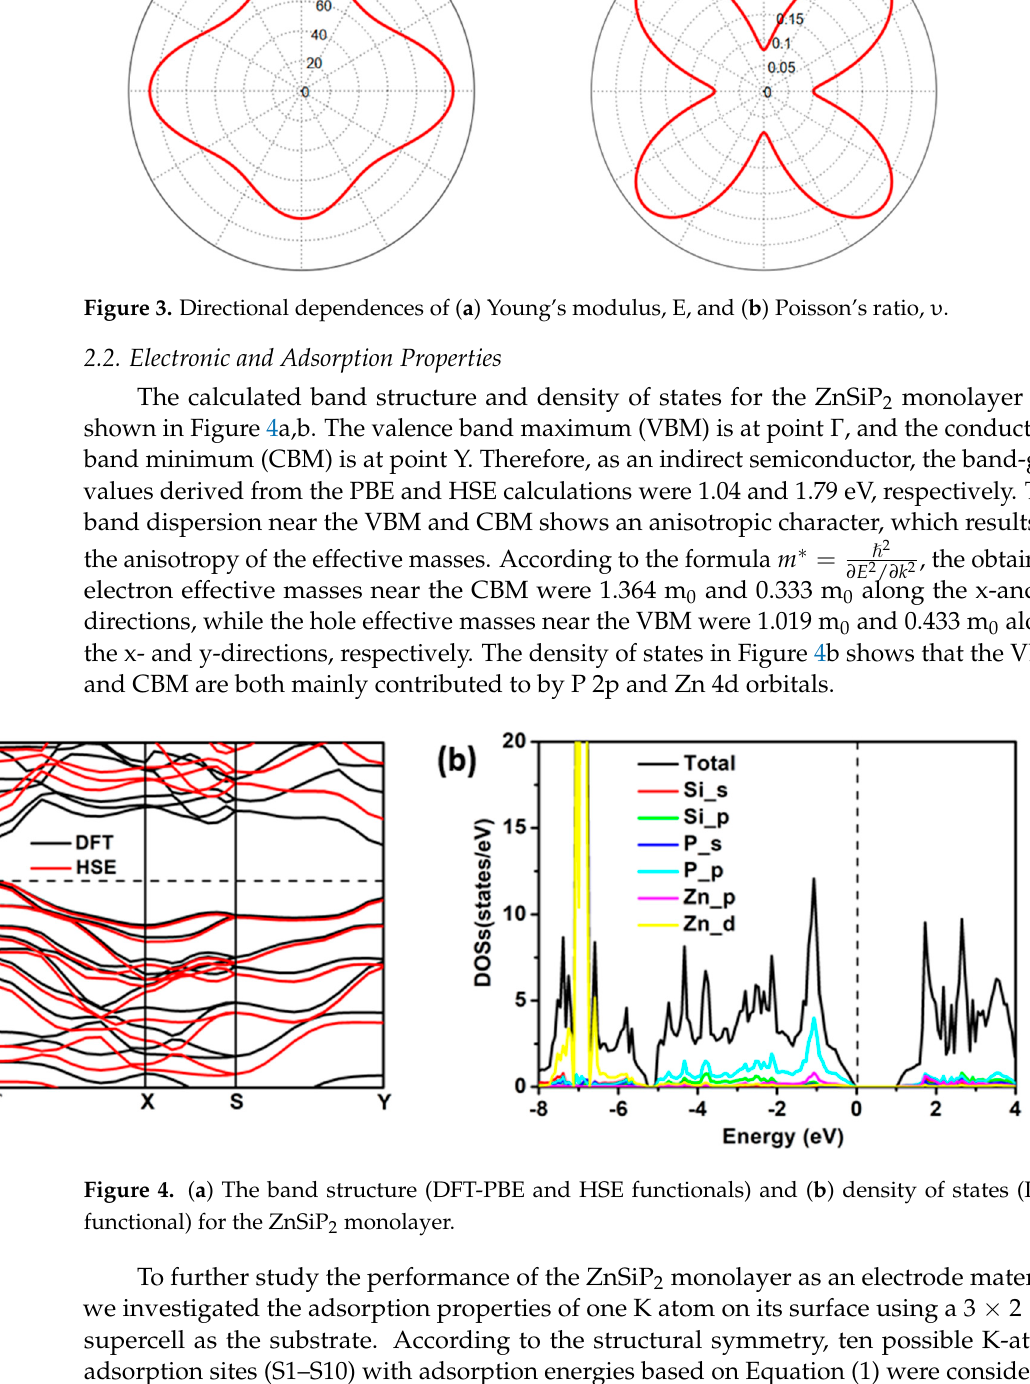
Figure 4. ( a ) The band structure (DFT-PBE and HSE functionals) and ( b ) density of states (PBE functional) for the ZnSiP 2 monolayer.